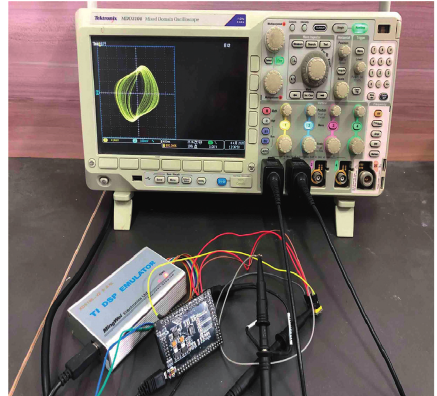
Figure 5: Hardware part of DSP